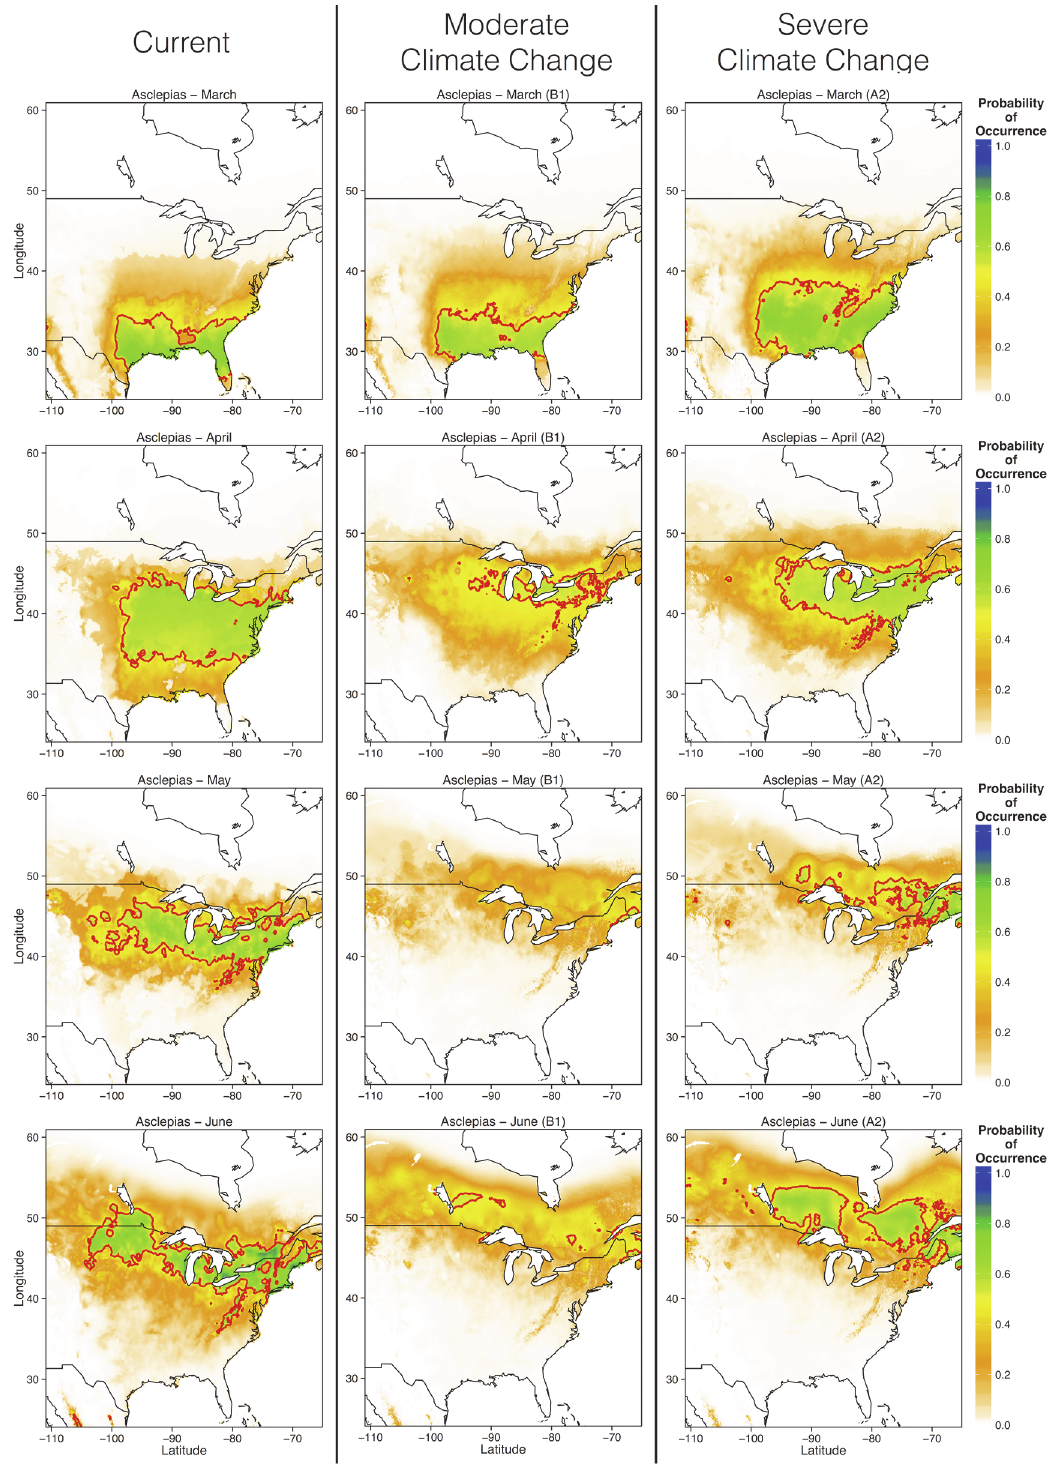
Fig 8. Ensemble projections of future Asclepias distributions during each of the spring months (March — June) under moderate and severe climate change scenarios. Ensemble projections were generated by averaging MaxEnt output from each of the four GCM